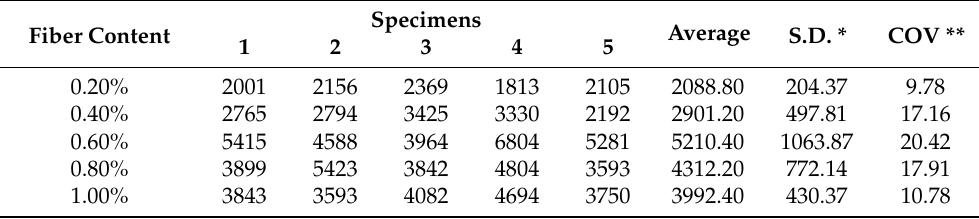
Table 5. Flexural toughness (Nmm).